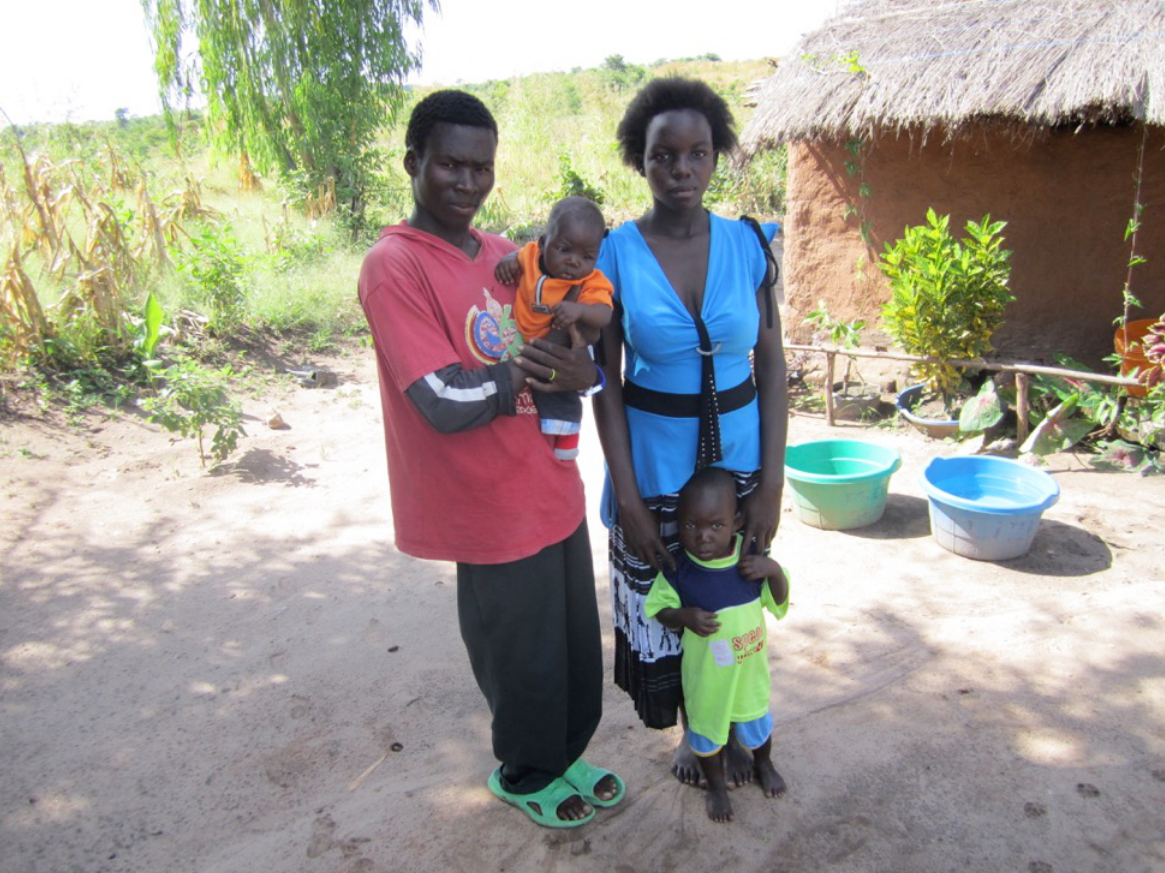
Photograph 3: Bricklayer (22) with his wife and their two